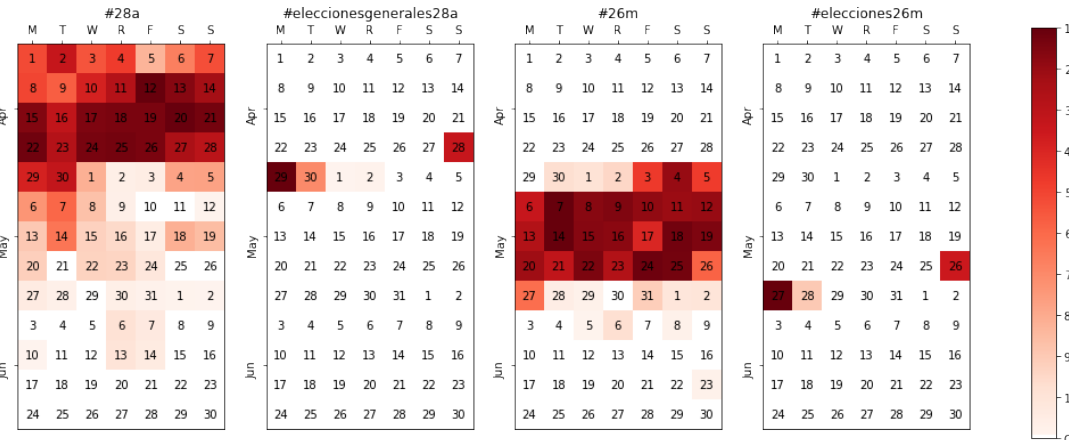
Figure 3. Tracking the relevancy of the general hashtags in the election period; notice how #28a (campaign) is followed by #eleccionesgenerales28a (results) and the interest in #26m surges right afterwards, also ending in a result-related topic (#elecciones26m) after the 26M vote.